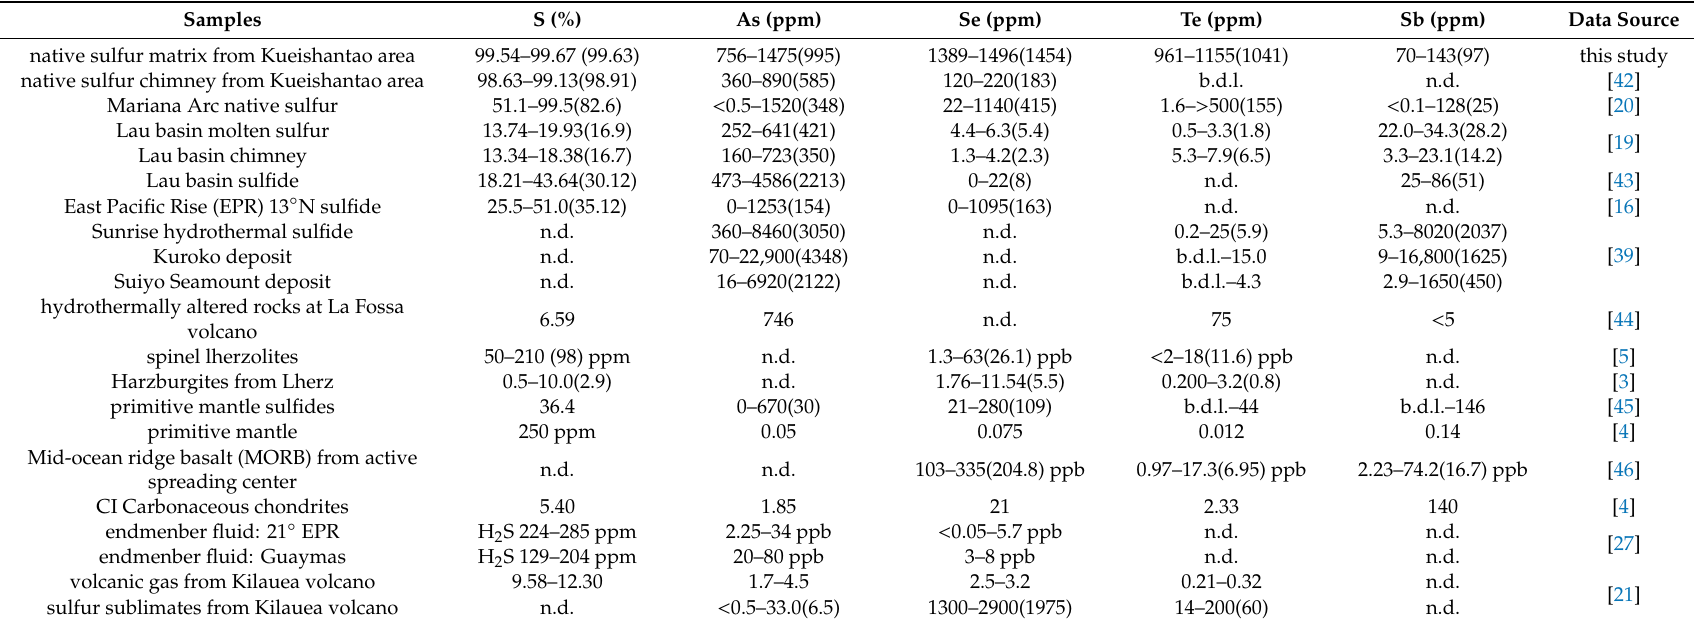
Table 2. Comparison of S, Se, Te, As, Sb data from this study with published data. The mean values are shown in brackets.